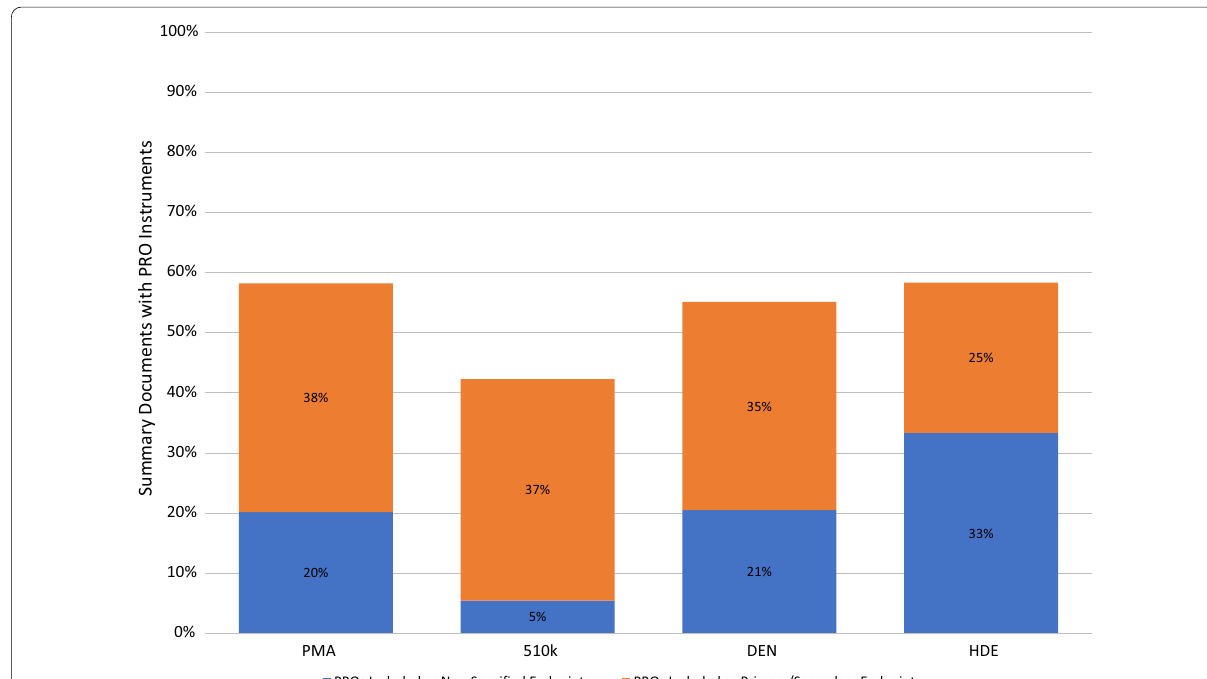
Fig. 2 Inclusion of PRO in summary documents, separated by endpoint positioning. Summary documents were grouped by device authorization pathway (premarket approval (PMA), premarket notification [510(k)], Device Classification Under Sect. 510(f) [2] (De Novo), Humanitarian Device Exemption (HDE)). Percentage of marketing authorizations that included a PRO in the summary documents (total bar), separated by the marketing authorizations that used at least one PRO as a primary or secondary endpoint (orange) and those that included PROs as supporting data, either to support ancillary endpoints or without specifying endpoint positioning